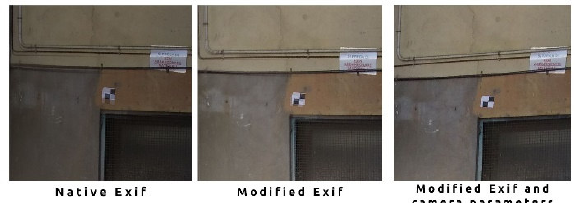
Figure 9. Stitching aberration related with the use of different approach for camera interior parameters estimation. Figure 10. Sparse cloud. Tie point quality based on reprojection error. 360 configuration: automatic process with native Exif (A), process with modified Exif